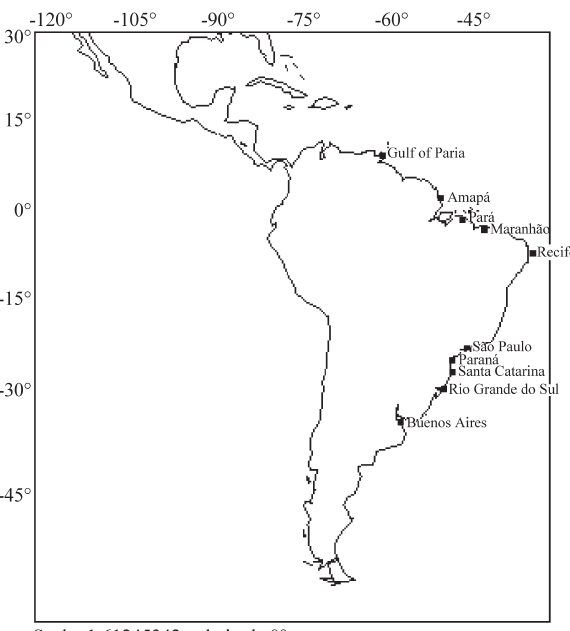
Figure 1 - Collection locations for Macrodon ancylodon of the western Atlantic